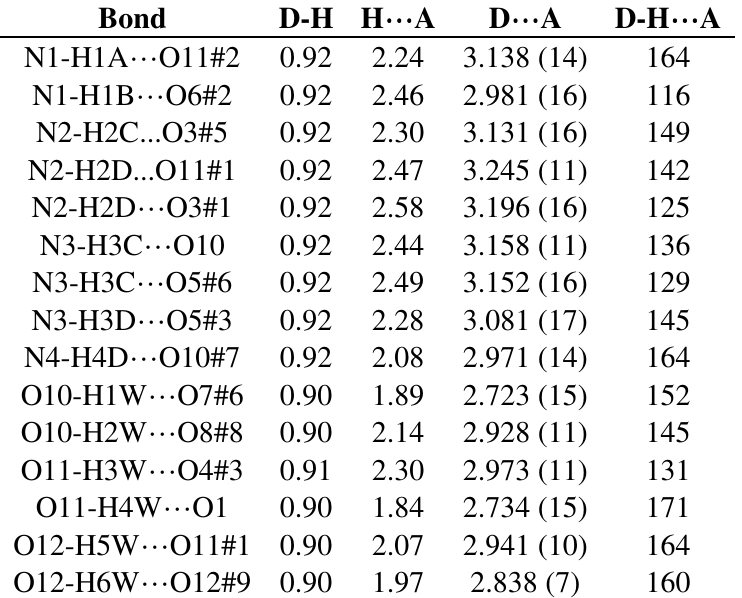
Table 2. Hydrogen bond geometries (Å and ° ) in 1 .